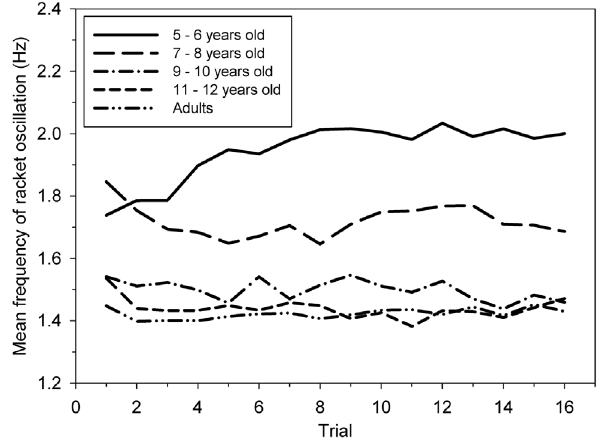
Figure 4. Mean racket frequency ( f r ) for the five age groups across